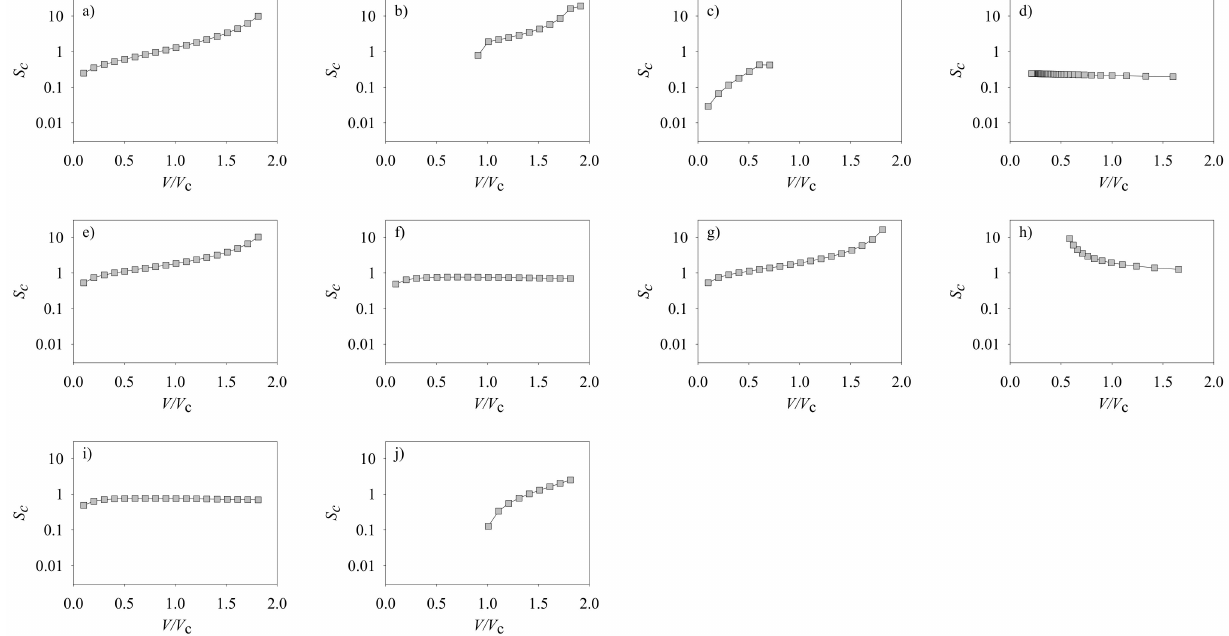
Figure 2. Sensitivity of the different scour prediction models to the critical velocity: ( a ) YHAN, ( b ) YBRE, ( c ) YJAF, ( d ) YJAI, ( e ) YKHA, ( f ) YMAS, ( g ) YGAO, ( h ) YSGAO, ( i ) YMEL, ( j )